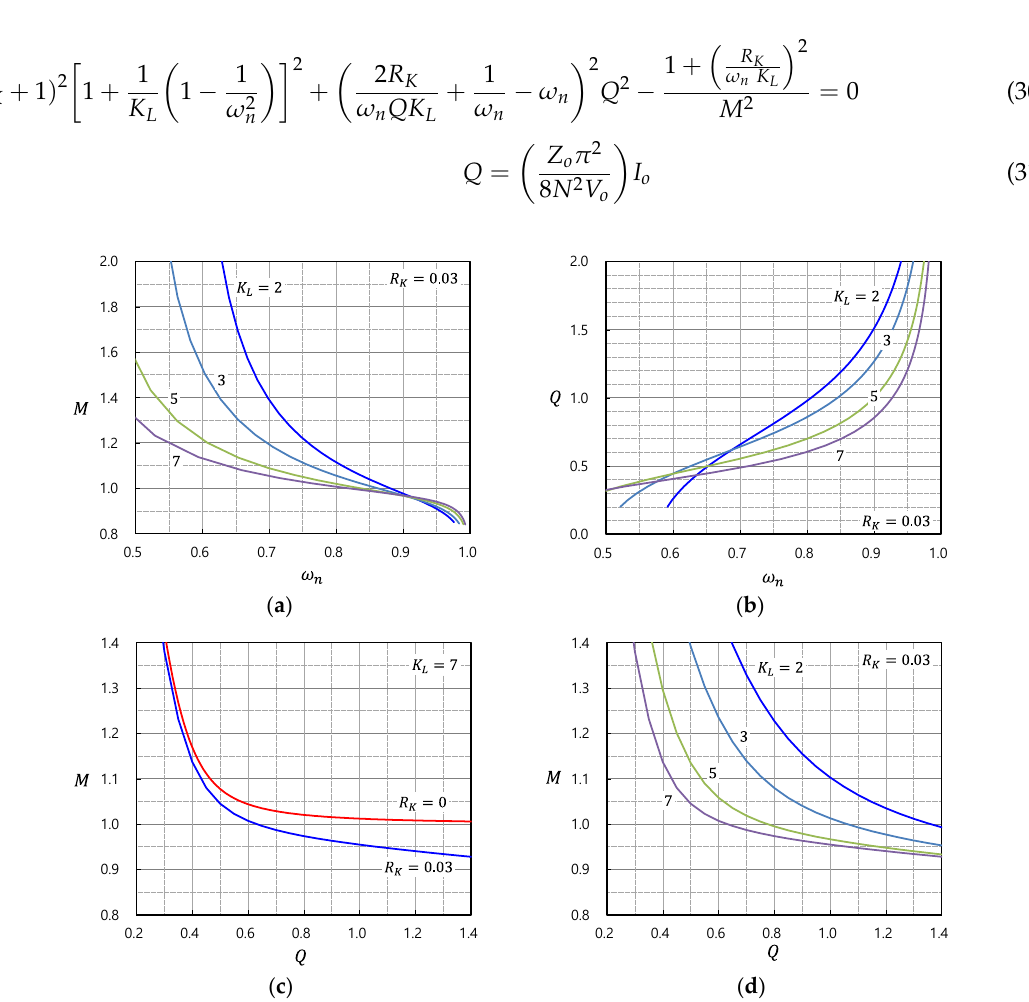
Figure 11. Characteristic graph of peak DC voltage gain M : ( a ) Peak DC voltage gain M vs. normalized frequency ω n ; ( b ) Q vs. Normalized frequency ω n ; ( c ) DC voltage gain M in accordance with internal loss resistance R K ; and ( d ) DC voltage gain M in accordance with inductance ratio K L